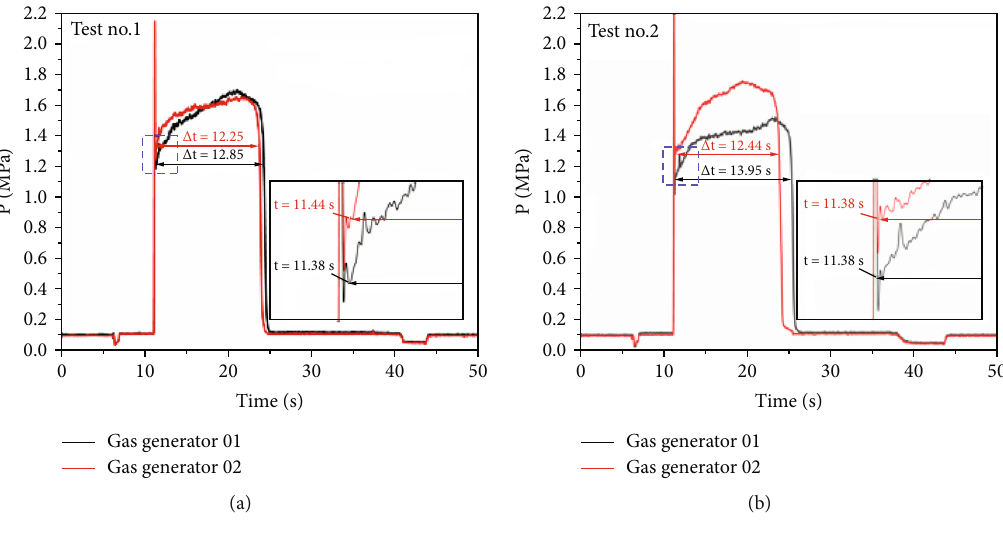
Figure 7: Pressure evolution in the gas generator.